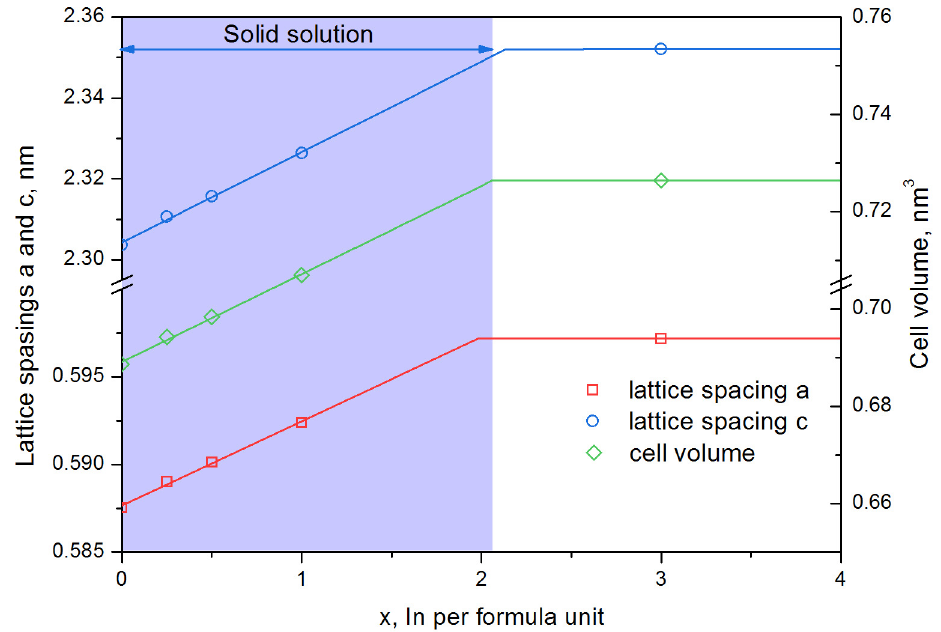
Figure 2. Dependence of lattice spacings and cell volume of the SrFe 12 − x In x O 19 phase on the degree of alloying by In, after annealing at 1200 ◦ C for 1